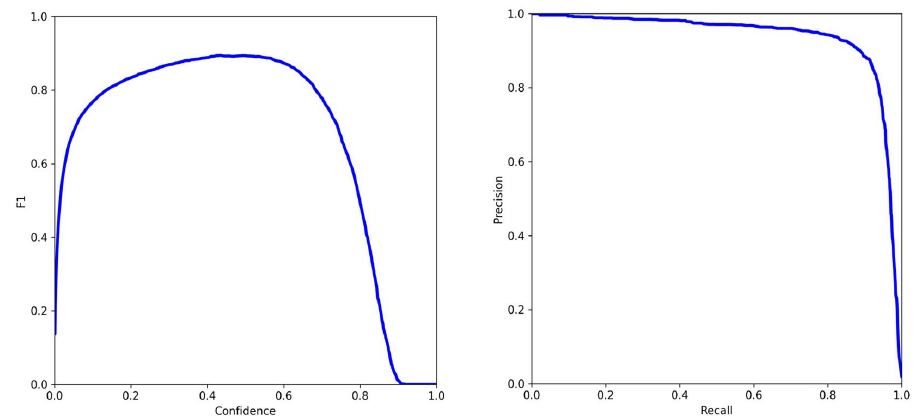
Figure 17. The F1–Confidence curve and P–R curve. ( a ) F1–Confidence curve. ( b ) P–R curve.